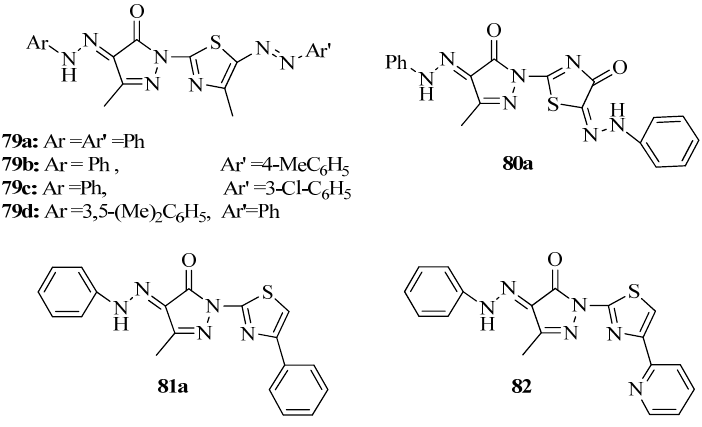
Figure 31. Structures of thiazolyl-pyrazole